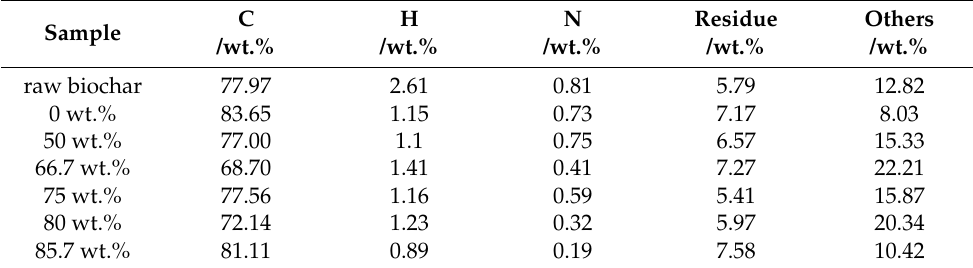
Table 4. Percentage of elements in KOH-activated